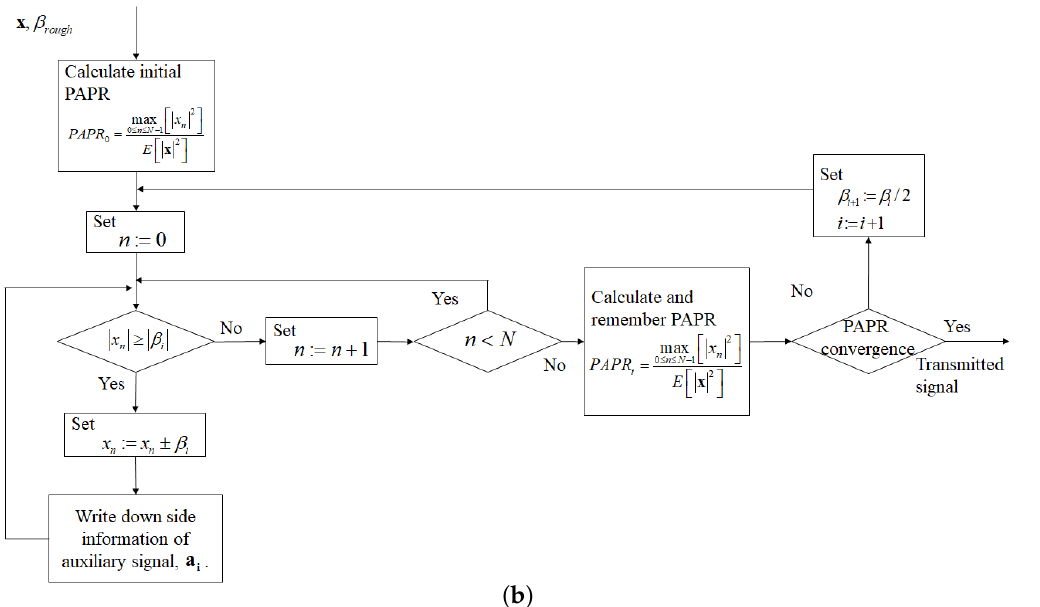
Figure 7. The block diagram of the proposed scheme in ( a ) the first stage and ( b ) the second stage.